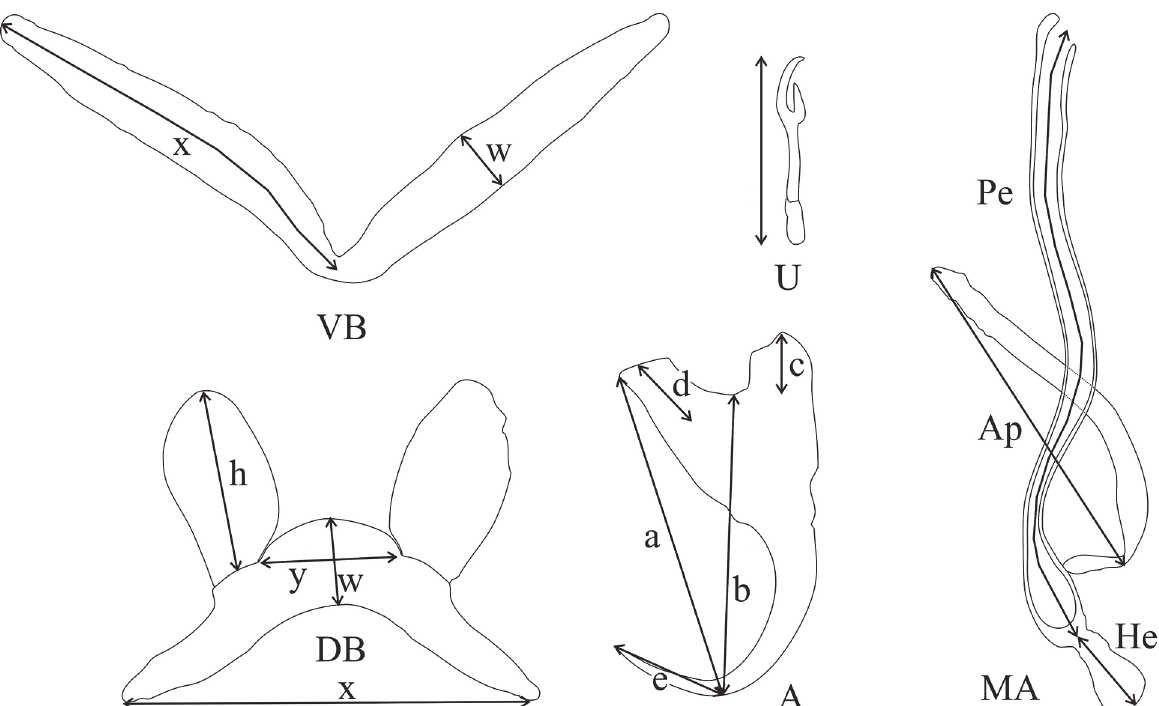
Fig 1. Measurements used to study the new Cichlidogyrus species. (DB) dorsal transverse bar: (h) length of dorsal bar auricle, (w) dorsal bar maximum width, (x) dorsal bar total length, (y) distance between auricles. (A) anchor: (a) anchor total length, (b) anchor blade length, (c) anchor shaft length, (d) anchor guard length, (e) anchor point length (both dorsal and ventral anchors were examined). (MA) male apparatus: (Ap) accessory piece length, (Pe) penis total length, (He) heel length. (U) uncinuli length. (VB) ventral transverse bar: (w) ventral bar maximum width, (x) length of one ventral bar branch.